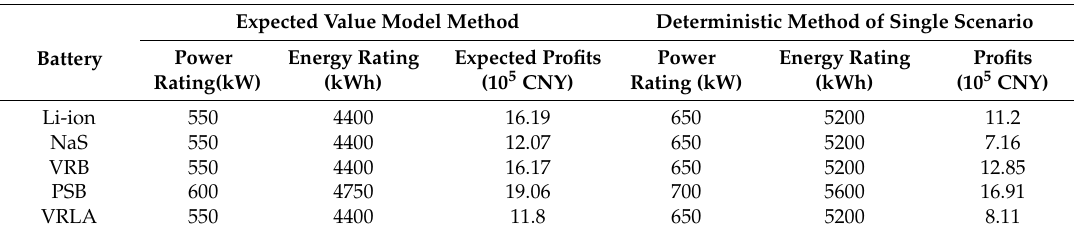
Table 4. The comparison of different batteries’ results obtained by two optimization methods.